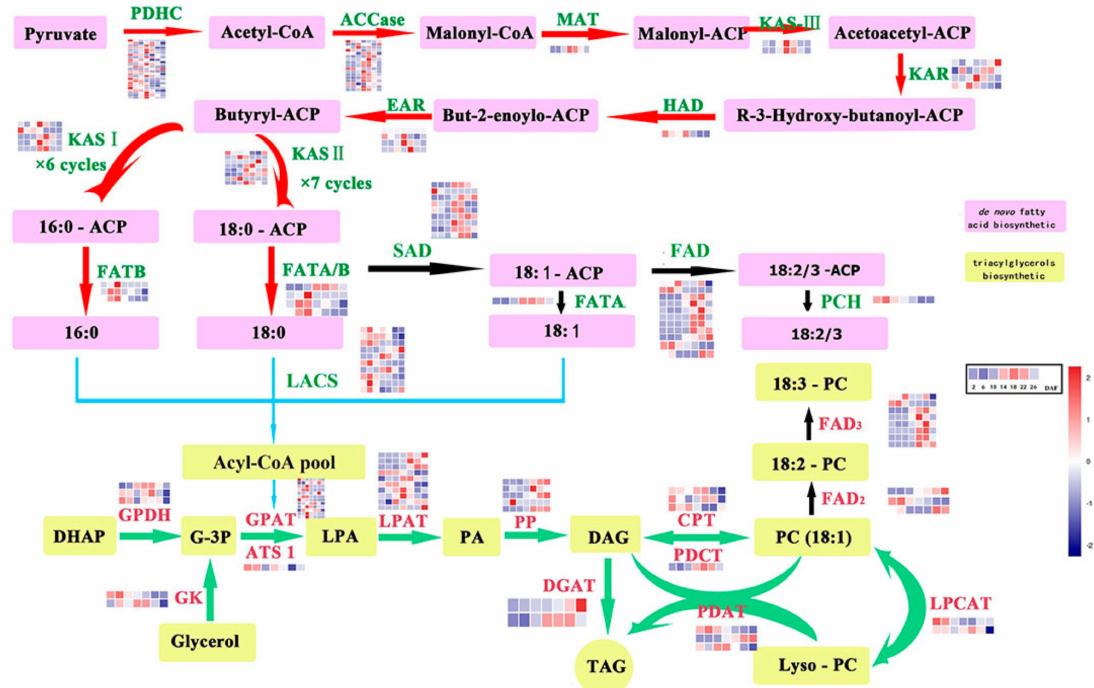
Figure 2. Perilla sequences associated with fatty acid biosynthetic pathway. Each row represents a gene, and each column represents a specimen (stage). Depths of color in the red and blue rectangles indicate higher and lower represents the Z-score RNA expression lever. Identified enzymes